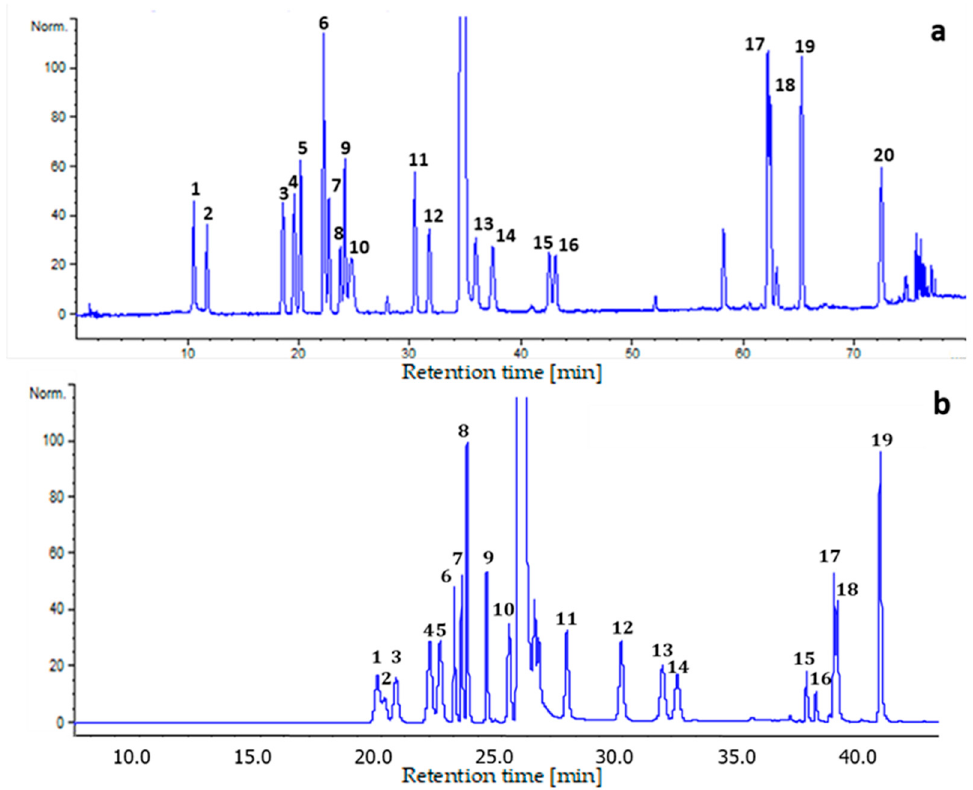
Figure 1. Chromatograms of standard solutions. ( a ) Method 1, mobile phase A: 40 mM aqueous